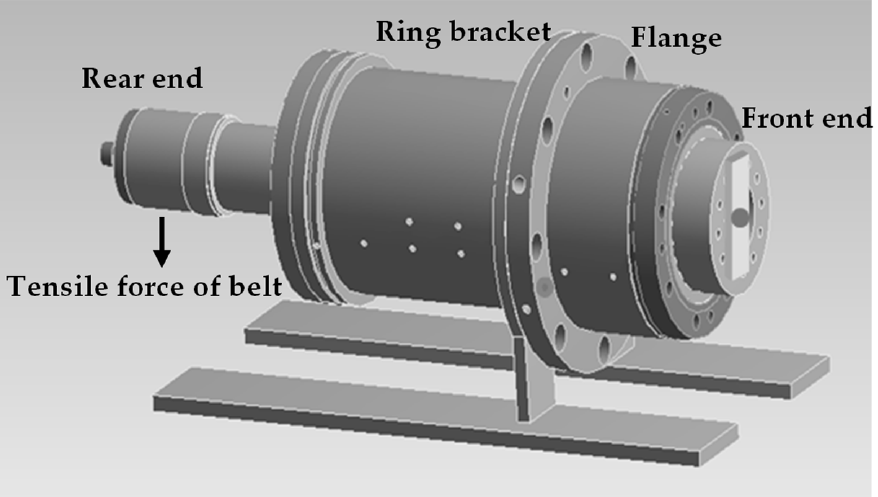
Figure 5. The schematic diagram of the spindle screwed to the ring bracket of the running-in platform through its flange.